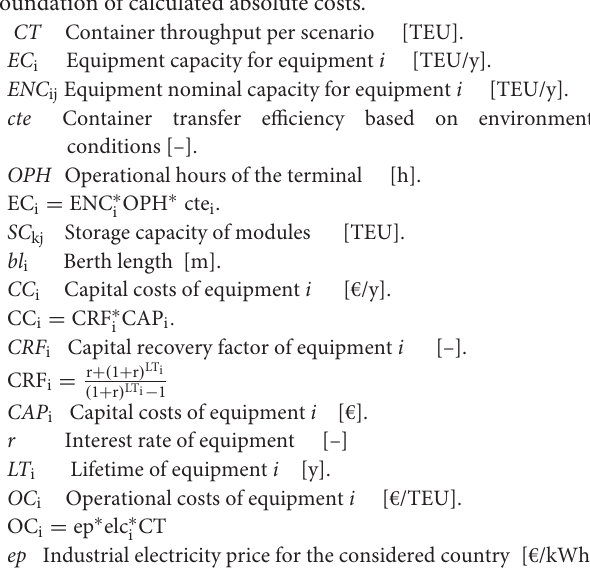
defined the floating terminal’s layout design and the throughput scenarios, a logistics optimization is performed for static as well as for time-dependent scenarios, assuming yearly growths